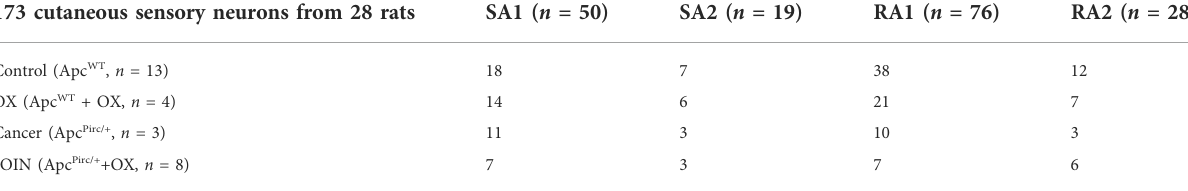
TABLE 2 Distribution of data. Breakdown of neuronal classes in top row and experimental group left most column. 173 cutaneous sensory neurons from 28